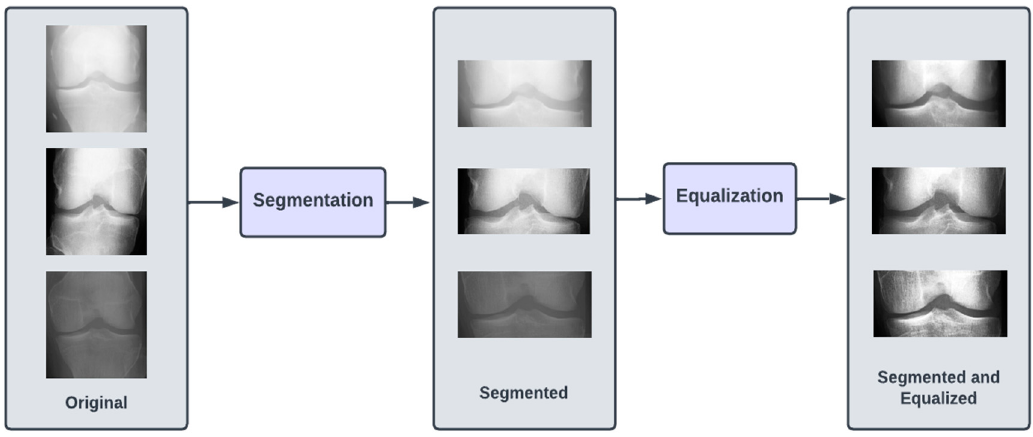
Figure 2. Preprocessing steps involved in proposed approach for KOA detection.